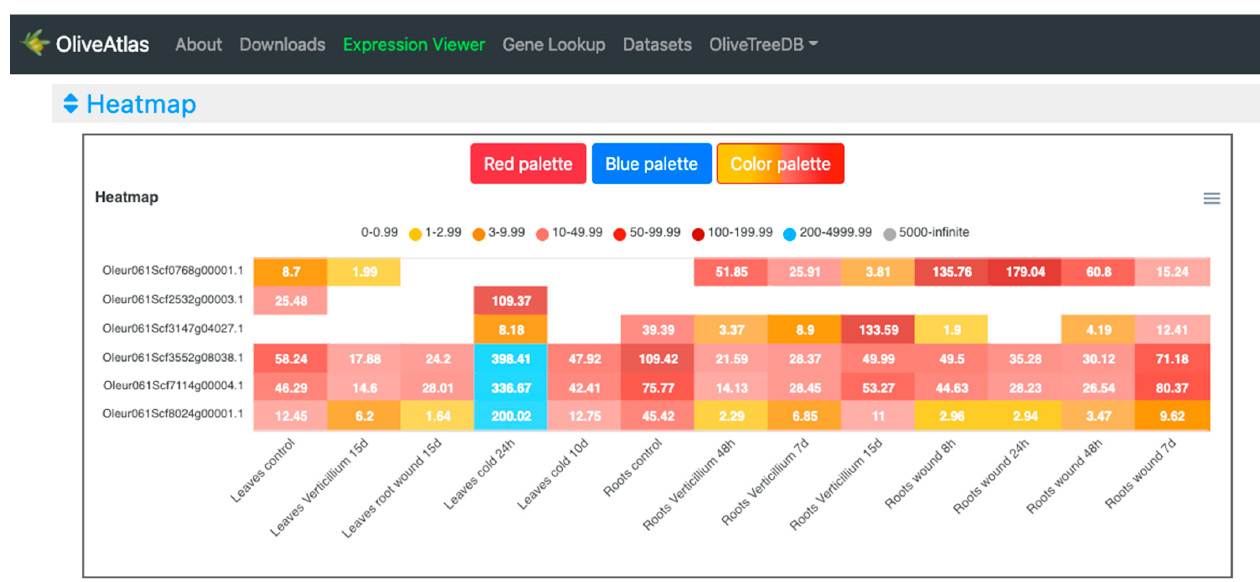
Figure 6. Heatmap visualization of the “Expression viewer” in OliveAtlas. Expression data are dis- played grouped by color in several ranges of expression. Three different color palettes are available.